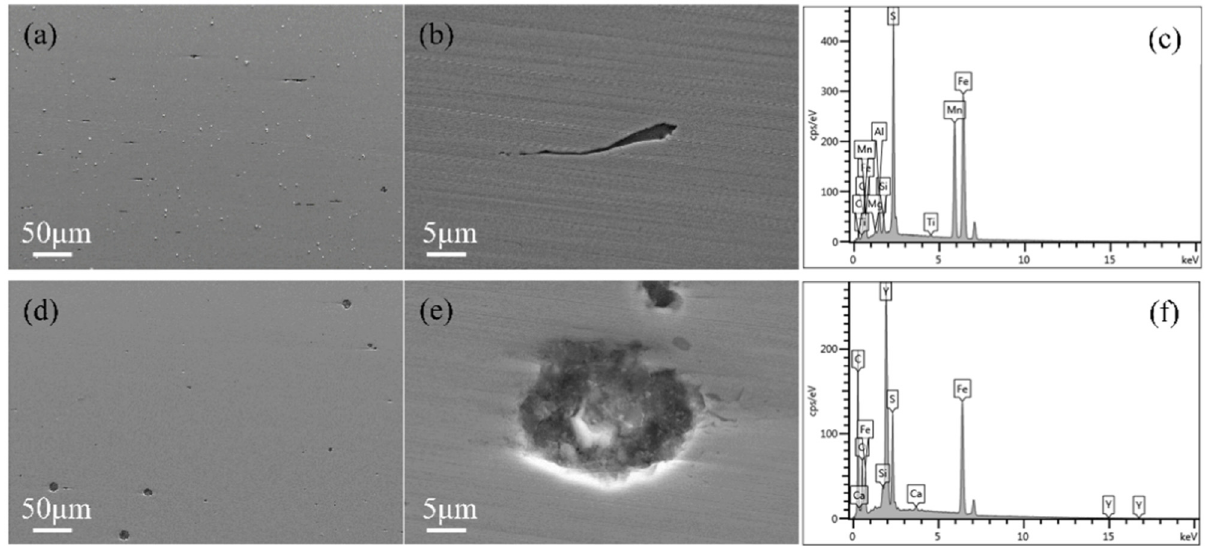
Figure 1: Morphology and chemical composition of inclusions in hot - rolled sheets of oriented silicon steel: ( a ) – ( c ) Y - free steel; ( d ) – ( f ) Y - bearing steel.